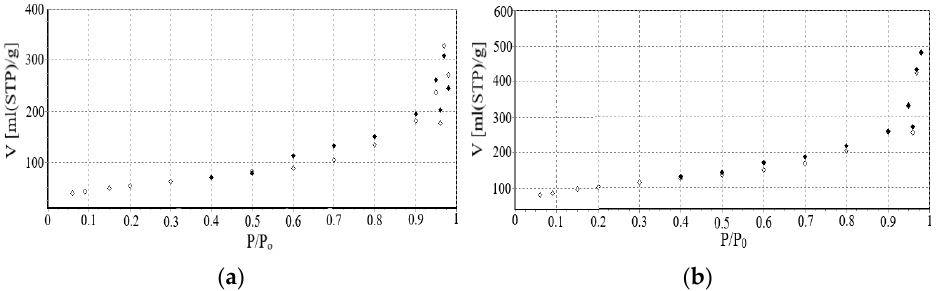
Figure 2. Isotherms of leached chrysotile adsorption and NiCo/chrysotile nanocatalyst: ( a ) leached chrysotile; ( b ) NiCo nanocatalyst/chrysotile.